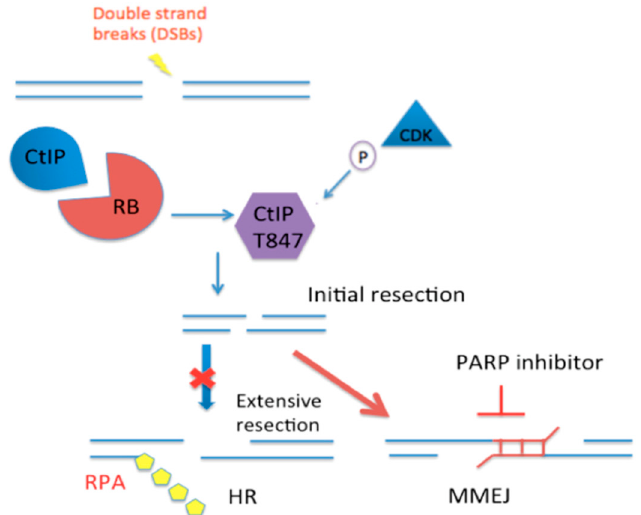
Figure 5. Proposed mechanism of RB in regulating CtIP mediated end resection for DSB-repair pathway choice. PARP1 inhibitor specifically blocking MMEJ may sensitize RB-deficient cells to co-treatment with PARP inhibitor and camptothecin. The red cross indicates inhibition of the extensive resection. The red arrow shows the initial resection would lead to MMEJ.